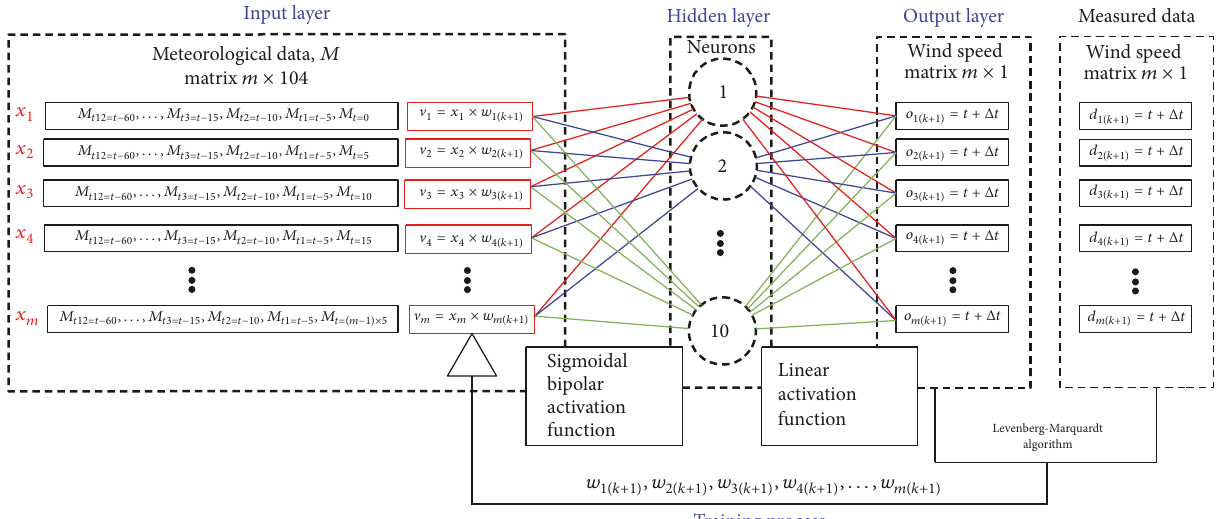
Figure 2: Schematic presentation of the artificial neural network prediction model ( 𝑥 1,2,3,...,𝑚 : input matrix data; 𝑀 𝑡=(𝑚−1)×5 : input data set of meteorological data (wind speed, wind direction, wind run, high wind speed, high wind direction, air temperature, air humidity, and air pressure), 𝑤 1,2,3,...,𝑚 : weight coefficient; V 𝑘 : sum of input matrix and weight coefficient products in 𝑘 th iteration of the training process; 𝑜 𝑘 : neuron response for 𝑡 = Δ𝑡 in 𝑘 th iteration of the training process; 𝑑 𝑘 : measured